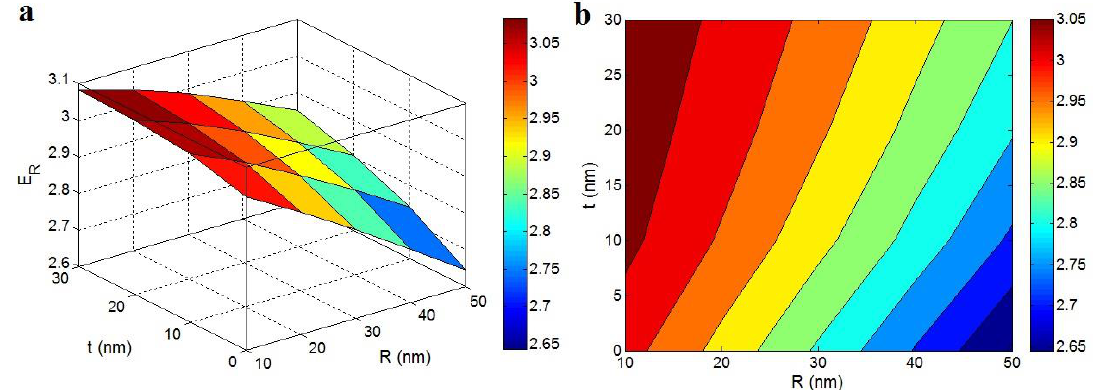
Figure 3. The relative modulus as a function of “ R ” and “ t ” terms by the Ouali model: ( a ) 3D and ( b ) contour plots.